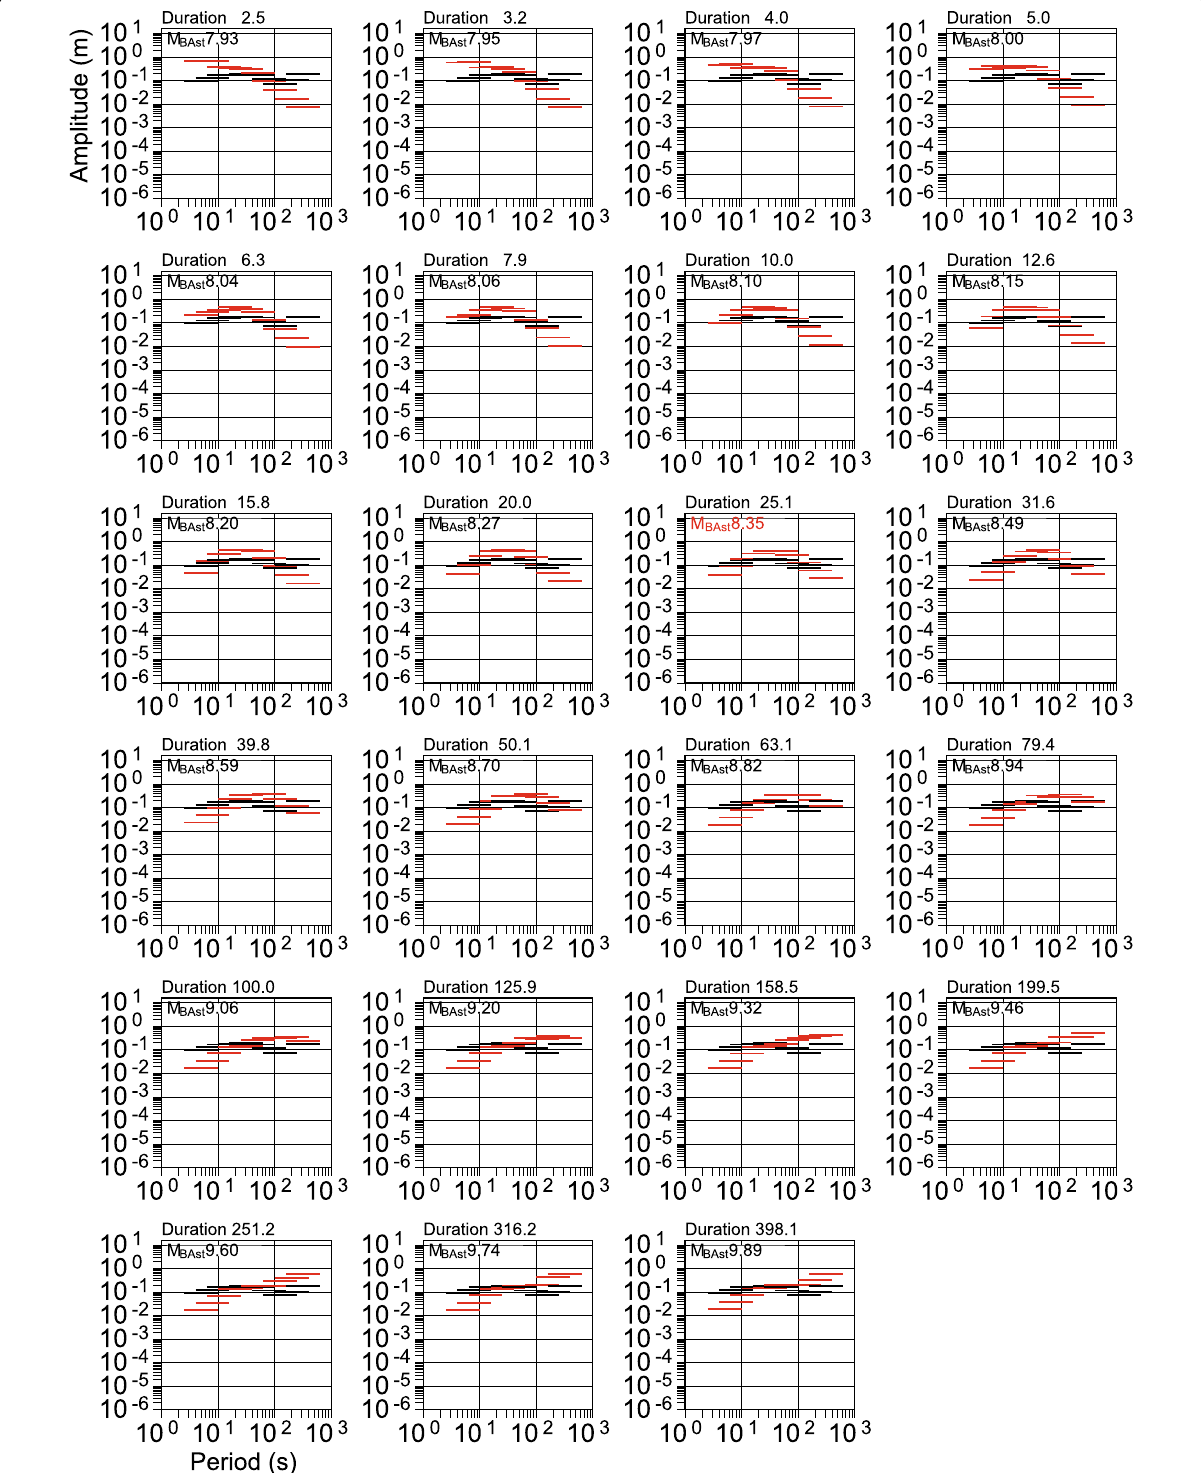
Fig. 6 Examples of multiband amplitude distributions of the 2003 Tokachi-oki earthquake in relation to seismic wave period. The black bars indicate observed peak displacements of the bandpass-filtered seismic record, and the red bars indicate those of the synthetic records fitted to the observation. The length of each bar shows the passband range. Each graph shows comparison for an assumed source duration. The estimate magnitude for each duration is indicated at the upper left of the graph. Duration of 25 s showed the best fit in this